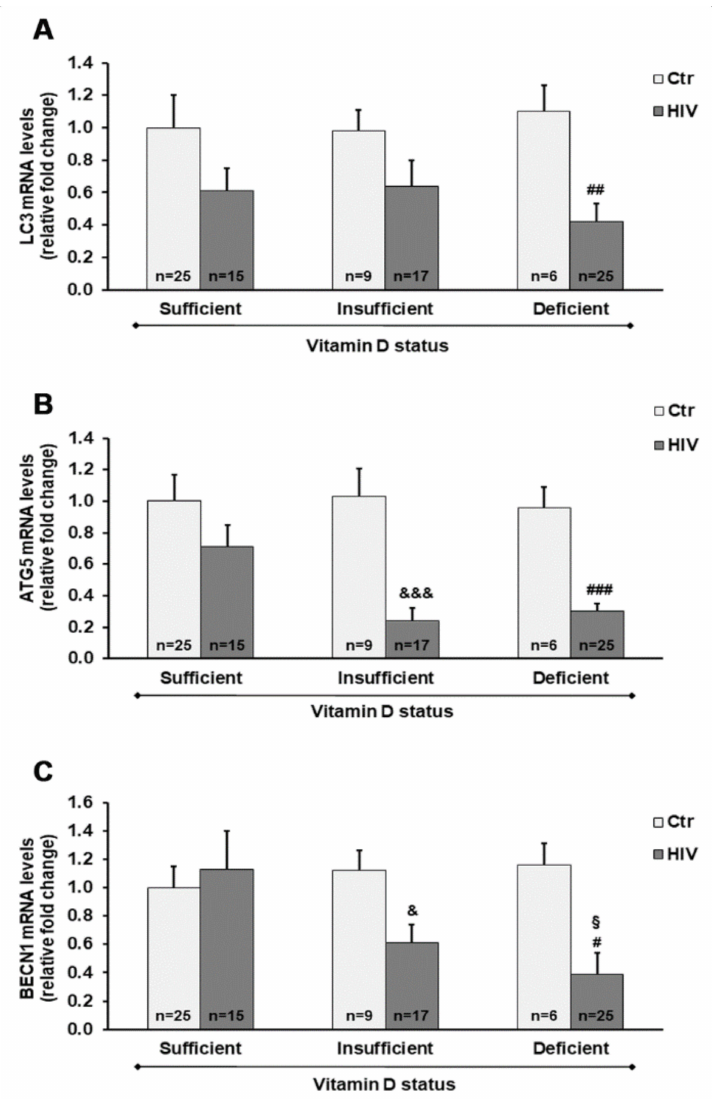
Figure 4. Gene expression of microtubule-associated protein 1A / 1B-light chain 3 ( LC3 ) ( A ), autophagy-related 5 homolog ( ATG5 ) ( B ), and Beclin 1 ( BECN1 ) ( C ) in PBMC from HIV + and healthy subjects. mRNA transcript levels were evaluated by real-time PCR. The results are expressed as mean ± SEM. & p < 0.05 and &&& p < 0.001 significant di ff erences in comparison to healthy subjects with insu ffi cient 25(OH)D 3 levels; # p < 0.05, ## p < 0.01, and ### p < 0.001 significant di ff erences in comparison to healthy subjects with deficient 25(OH)D 3 levels; § p < 0.05 significant di ff erence in comparison to HIV + subjects with su ffi cient 25(OH)D 3